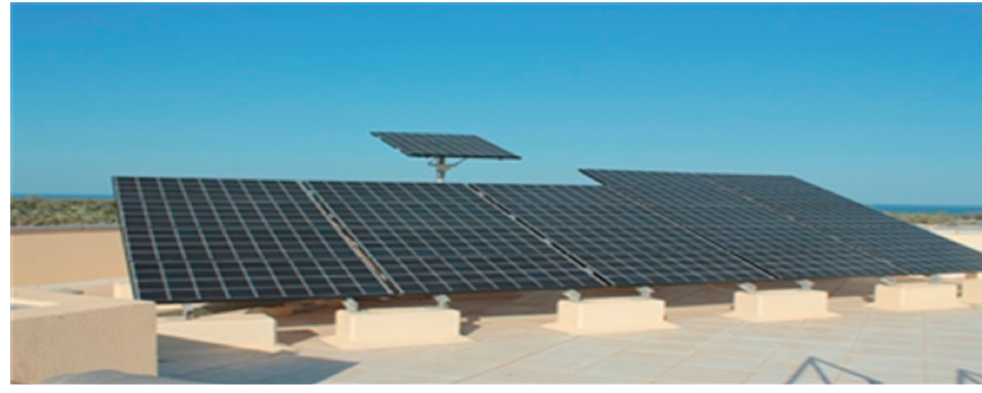
Figure 4. The PV system.